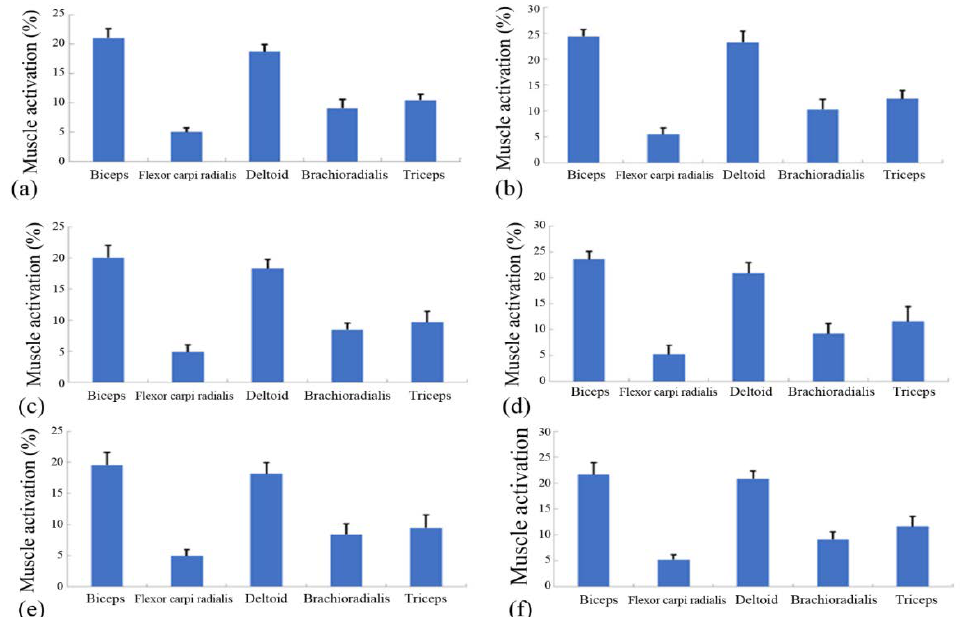
Figure 5. Muscle activation in different test scenarios. ( a ) Test scenario 1. ( b ) Test scenario 2. ( c )